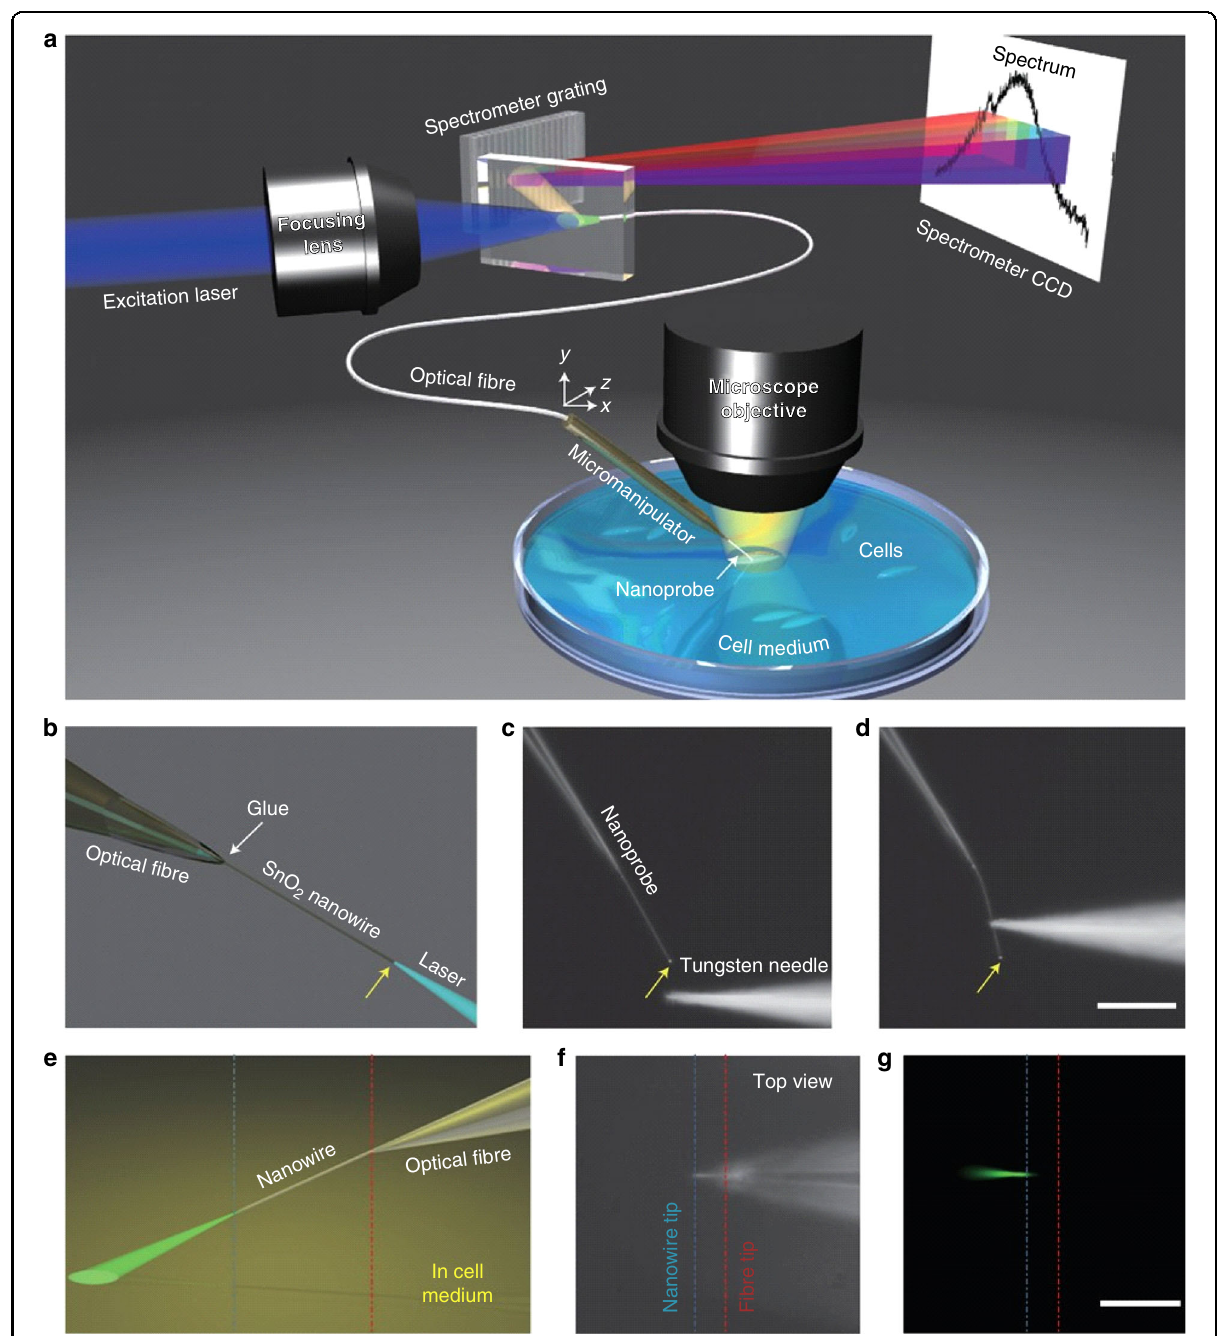
Fig. 1 Example of nanoprobing using optical fi bres combined with waveguiding materials tagged with fl uorescent QDs. a Diagram of a nanowire-based cell endoscope; b diagram of a blue laser waveguided through a SnO 2 nanowire attached to the tip of an optical fi bre; c , d dark- fi eld images of the nanowire-based cell endoscope before ( c ) and during ( d ) deformation by a tungsten needle to demonstrate its fl exibility and robustness. The yellow arrows in b – d indicate the position of the nanowire tip where light emission into free space occurs. e – g Intensity emission pro fi les for an endoscope immersed in a cell culture medium, in which fl uorescent proteins are illuminated with blue light from the nanowire tip; e diagram, f top-view dark- fi eld image, and g top-view fl uorescence image (a 442 nm longpass fi lter was applied). Scale bars 50 μ m. Reproduced from ref.